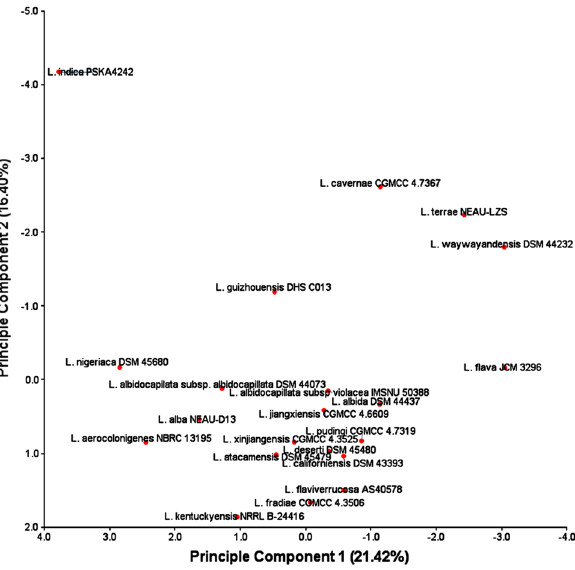
Figure 6. Principal component analysis (PCA) among Lentzea species based on BGCs recovered through antiSMASH for their